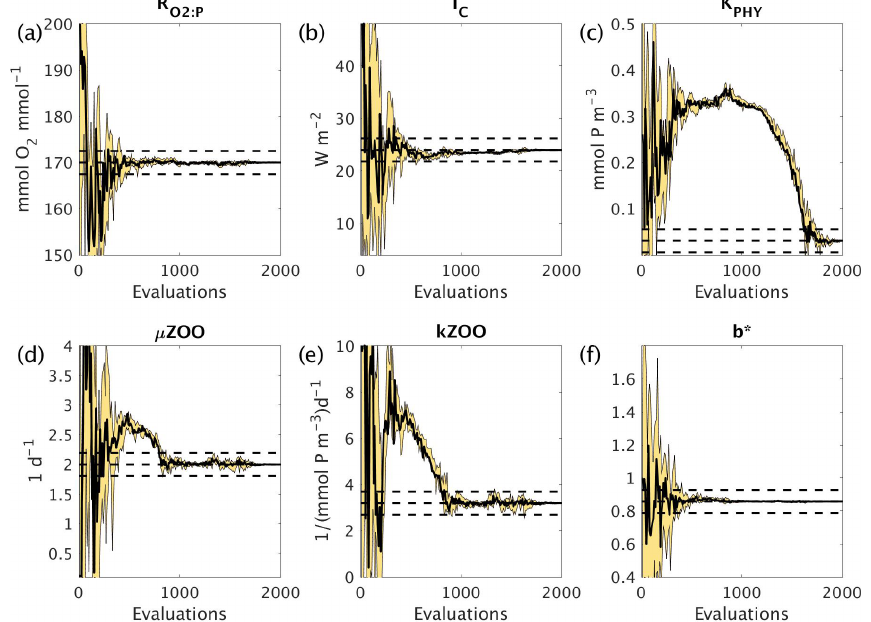
Figure 7. Parameter tuning by CMA-ES for the experiments C_SMOOTH for the parameters (a) R O (e) k ZOO and (f) b ∗ . There were 10 MOPS evaluations within each CMA-ES iteration (population λ = 10), run in parallel. Plotted are the parameter values associated with the minimum misfit of that population (thick black solid line), and the maximum and minimum of all parameter values within that population (thin black solid lines), with the area between shaded yellow. Also plotted are the MOPS-ref target parameter values and ± 5% recovery zone (horizontal black dashed lines).